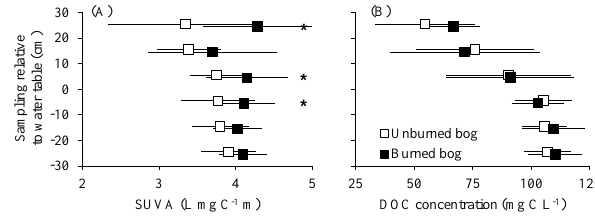
Fig. 4. Depth profiles of (A) SUVA and (B) DOC concentrations in an unburned and a burned bog. Averages ± 1 standard deviation are shown for samples taken within each 10cm depth segment. Sig- nificant differences ( t test, p < 0.05) between burned and unburned bogs are indicated ( ∗ ).